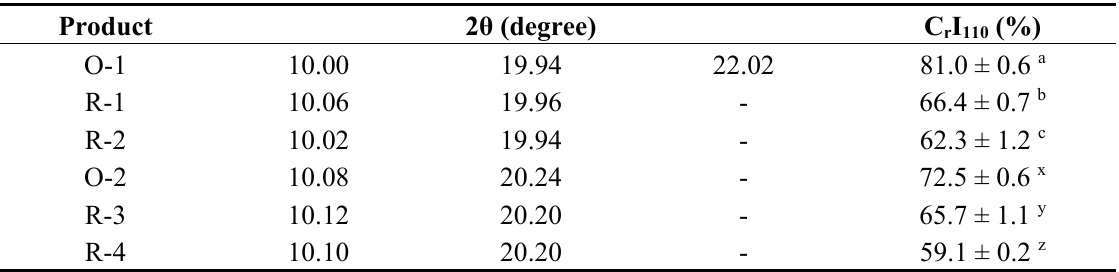
Figure 3. X-ray diffraction spectra of chitosans and regenerated chitosans. Samples O-1, R-1, R-2, O-2, R-3, and R-4, respectively, are described in Table 1. Table 2. Crystalline characteristics of various chitosan and regenerated chitosan products.